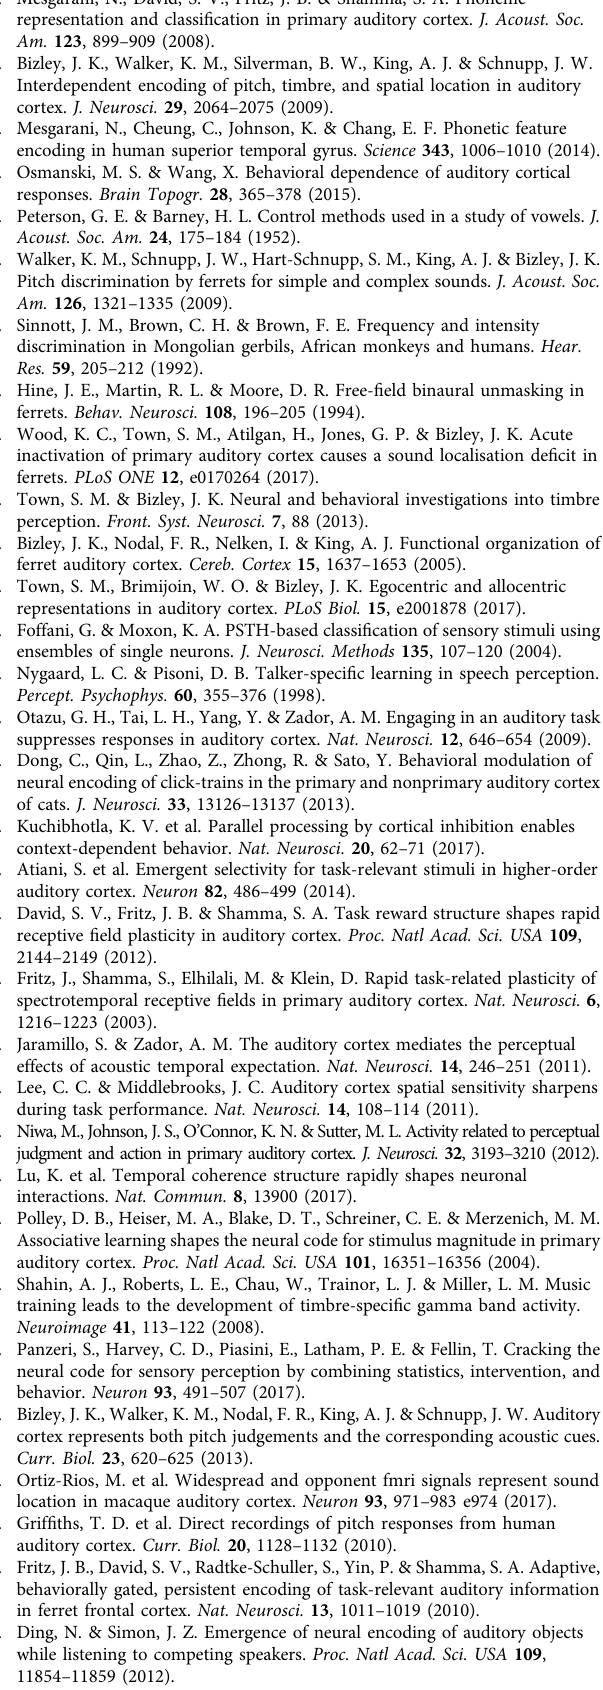
dimension. Decoding performance was compared for vowel identity, orthogonal values and for behavioral choice using a Wilcoxon sign-rank test. We compared the change in decoding performance between correct and error trials when decoding vowel identity and behavioral choice using a Wilcoxon rank-sum test.